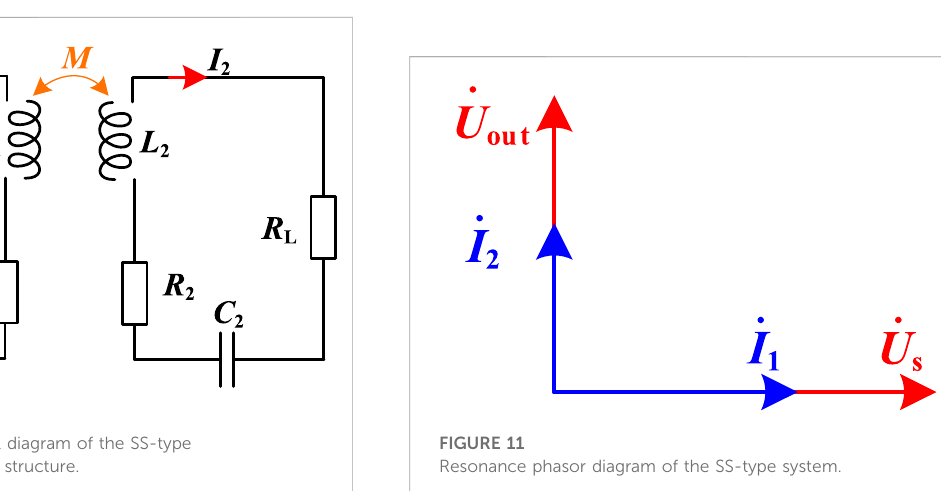
FIGURE 11 Resonance phasor diagram of the SS-type